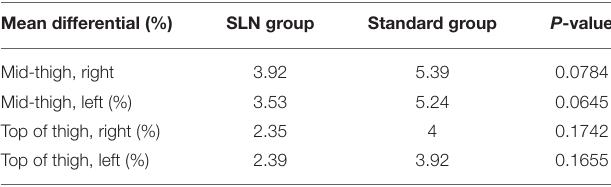
TABLE 3 | Percentage of increase of the circumferences of mid-thigh and top of thigh between the two groups (SLN alone vs. standard). Mean differential (%) SLN group Standard